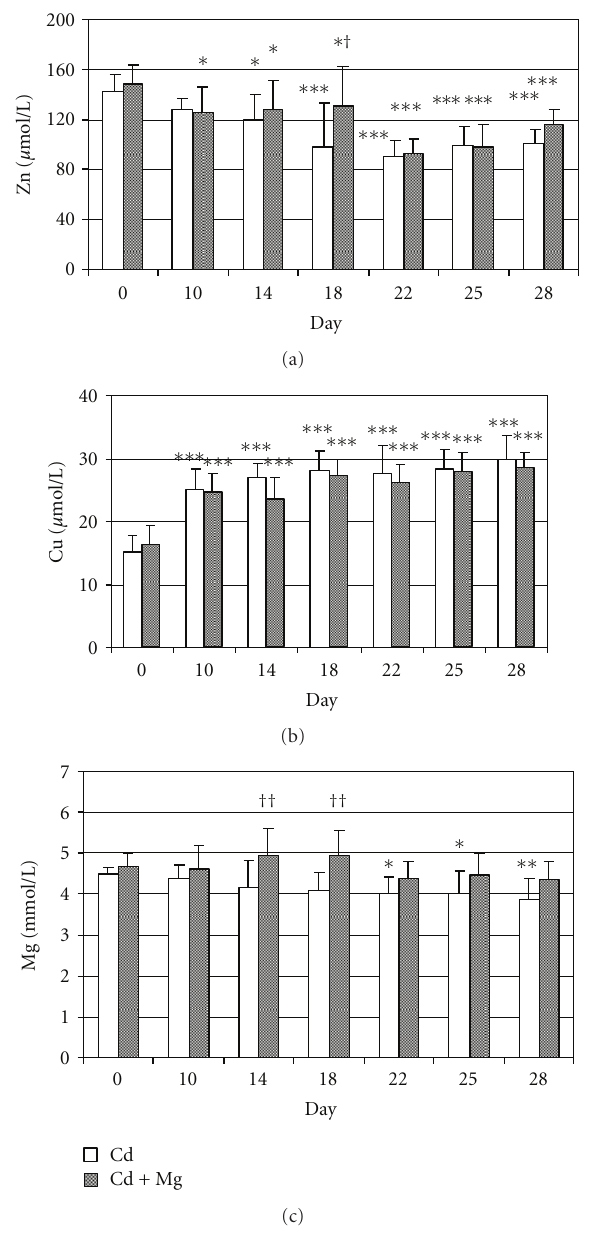
Figure 1: The e ff ect of Mg supplementation on Zn (a), Cu (b), and Mg (c) concentration in the blood of rabbits intoxicated with Cd. Cd group intoxicated orally for 4 weeks with 10mg Cd/kg b.w./day. Cd + Mg group given 40 mg Mg/kg b.w. 1h after Cd treatment. Marked values di ff er significantly (ANOVA + LSD test) from ∗ control (day 0) and † Cd group ( P < 0 . 05). ∗ , † P < 0 . 05; ∗∗ , †† P < 0 . 01; ∗∗∗ P < 0 .